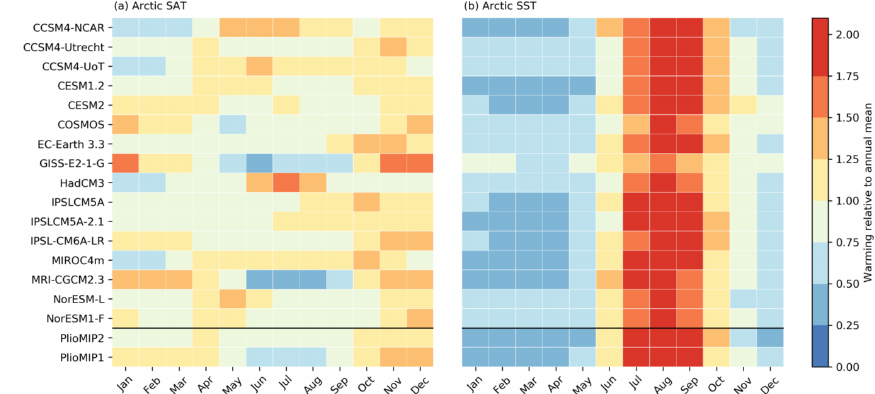
Figure 3. Ratio between the mean Arctic (a) SAT and (b) SST warming in a given month and the annual mean Arctic warming, for each model (and MMM) individually. Values of zero would imply no warming compared to pre-industrial period in a given month.